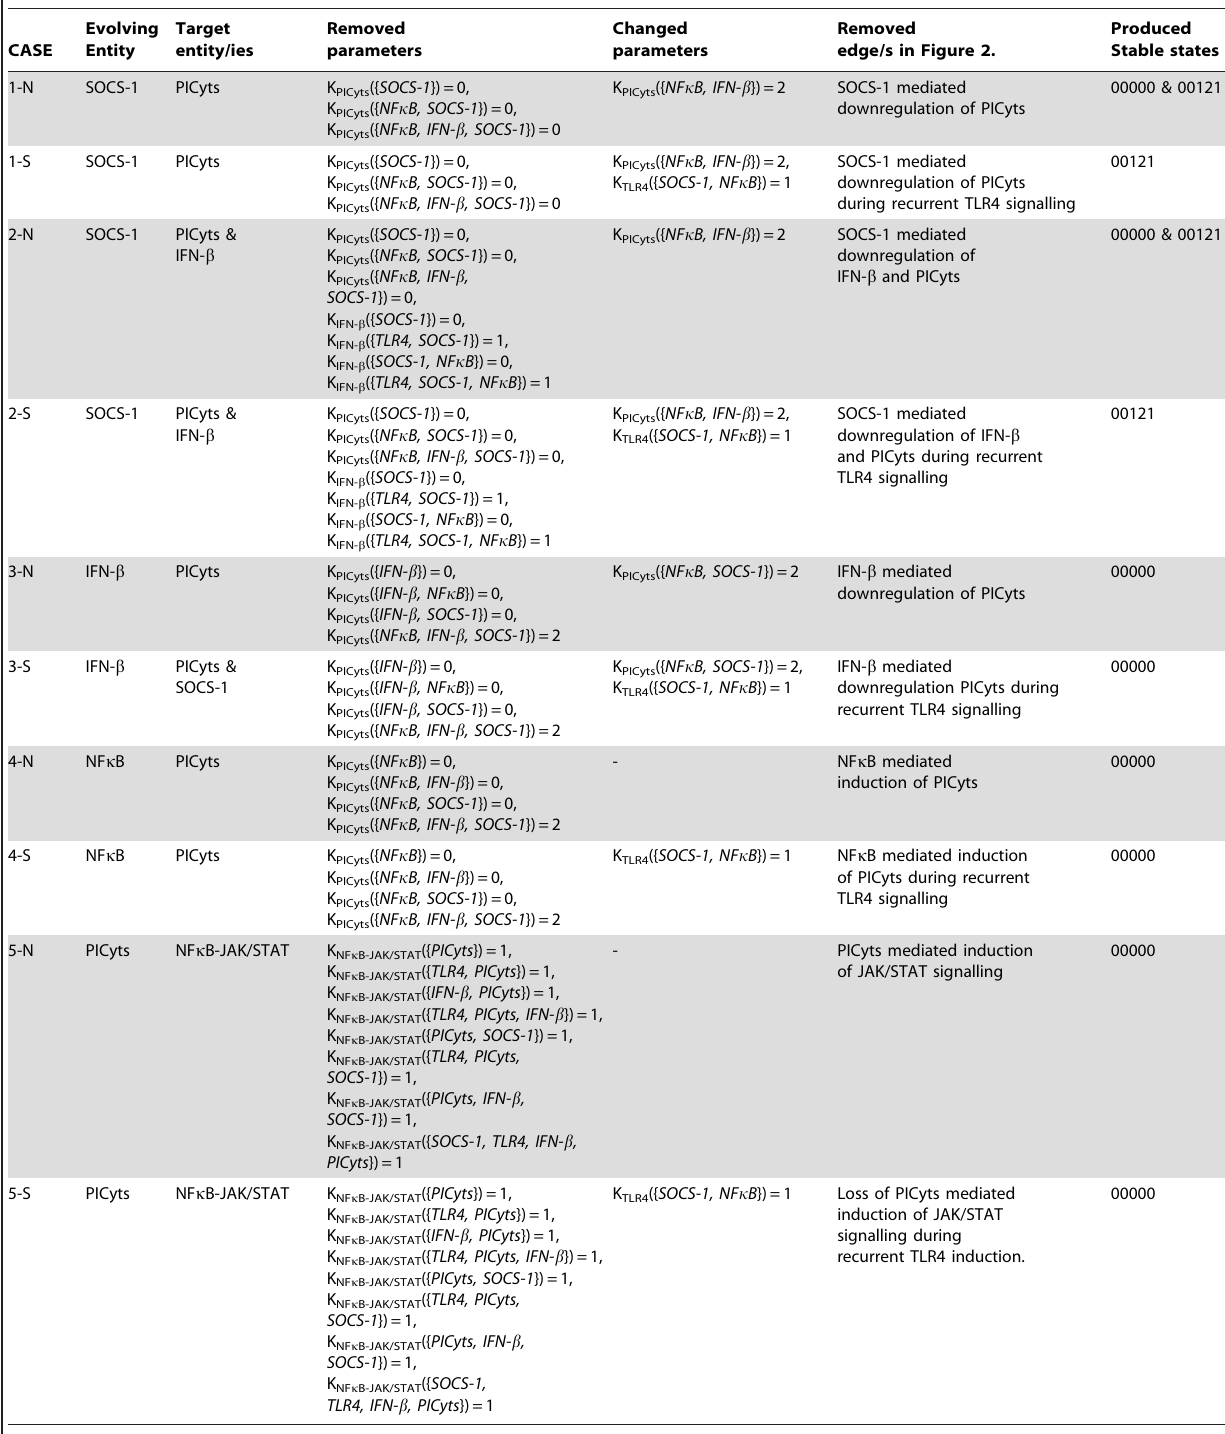
Table 3. Intervened